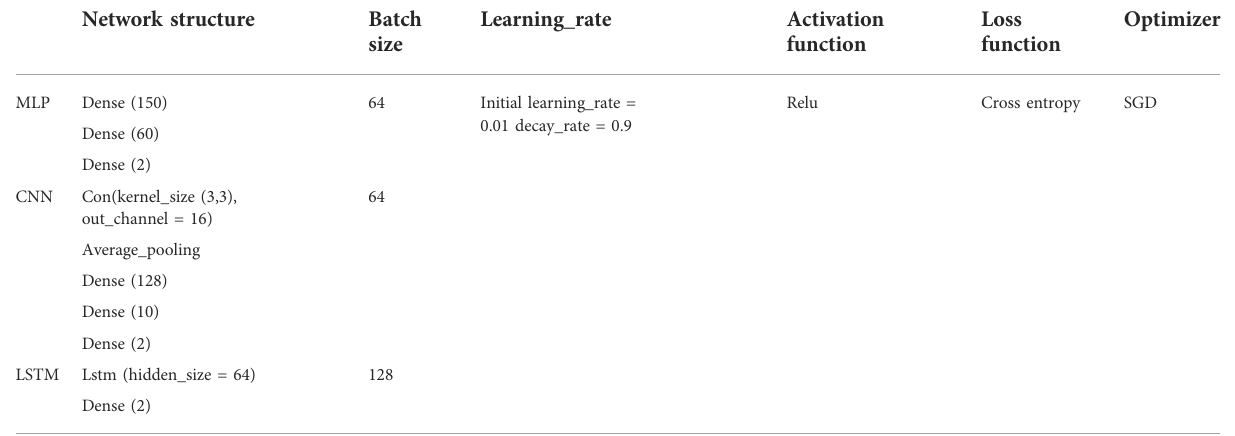
TABLE 1 Network structure and hyperparameters.